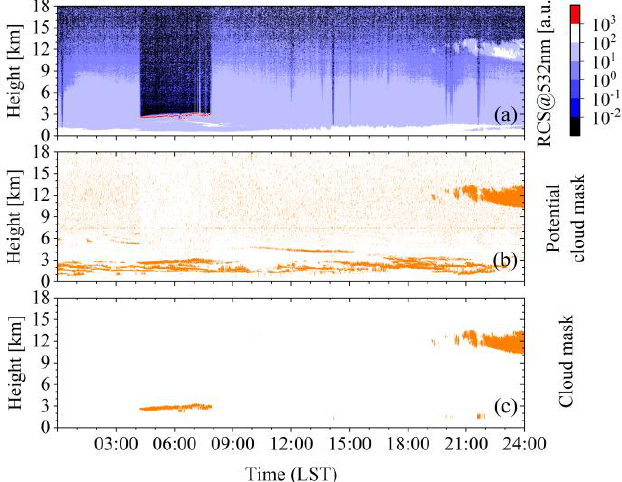
Figure 2. Flow chart of the cloud layer detection algorithm. Figure 3. A case of cloud layer detection: (a) The range-corrected signal at 532 nm; (b) the potential cloud mask after feature identification; (c) the cloud mask represents the cloud layers. This case was measured in Jinhua on June 5, 2013.